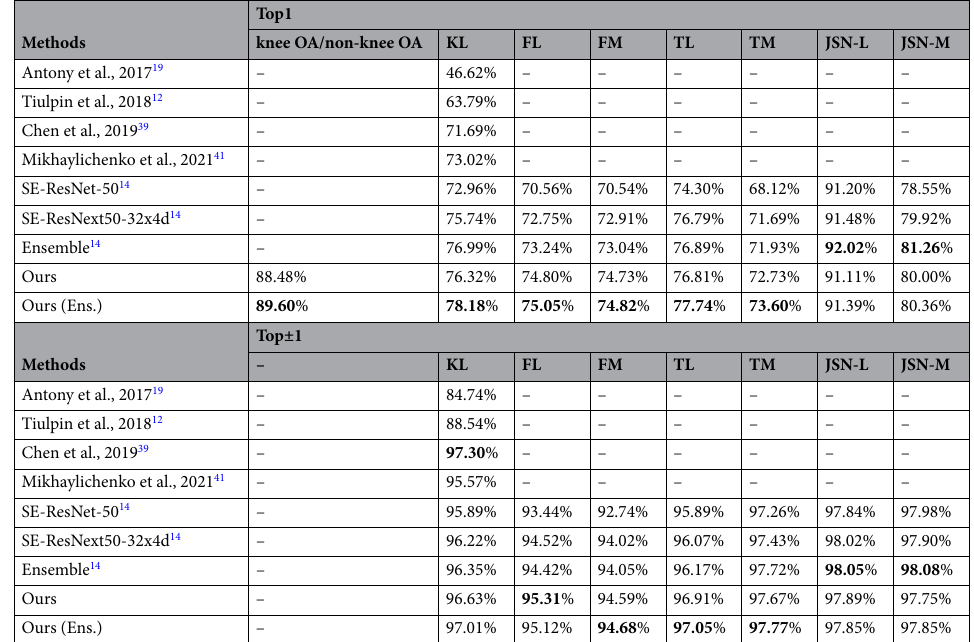
Ours Table 1. Performance comparison between the proposed method and other methods on the OAI dataset.